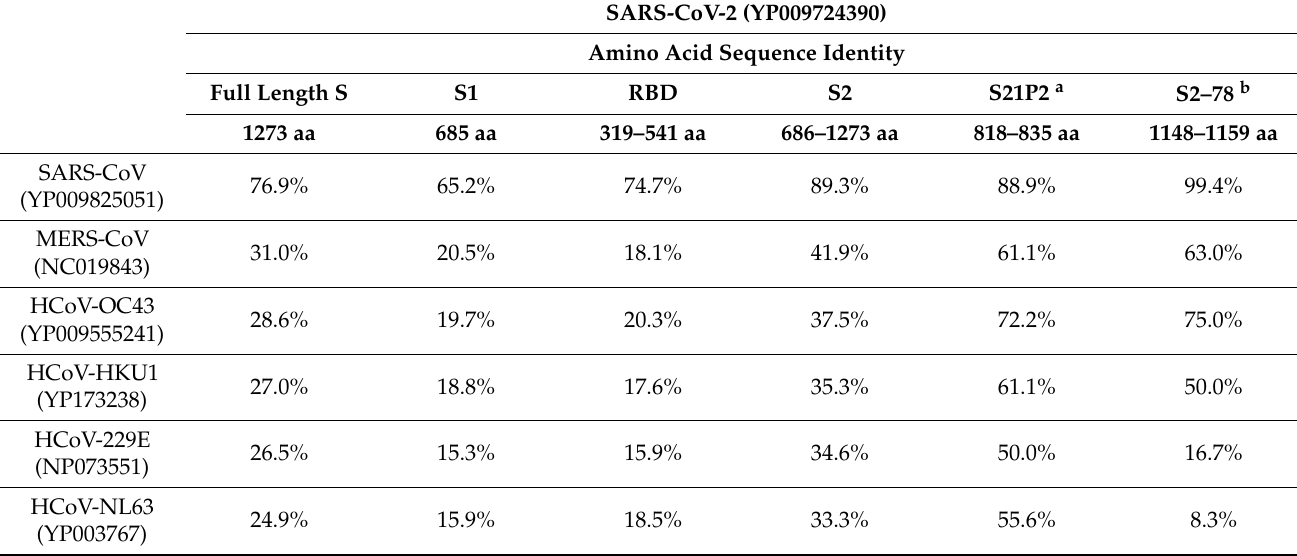
Table 1. The S and its component sequence identity between SARS-CoV-2 and other human